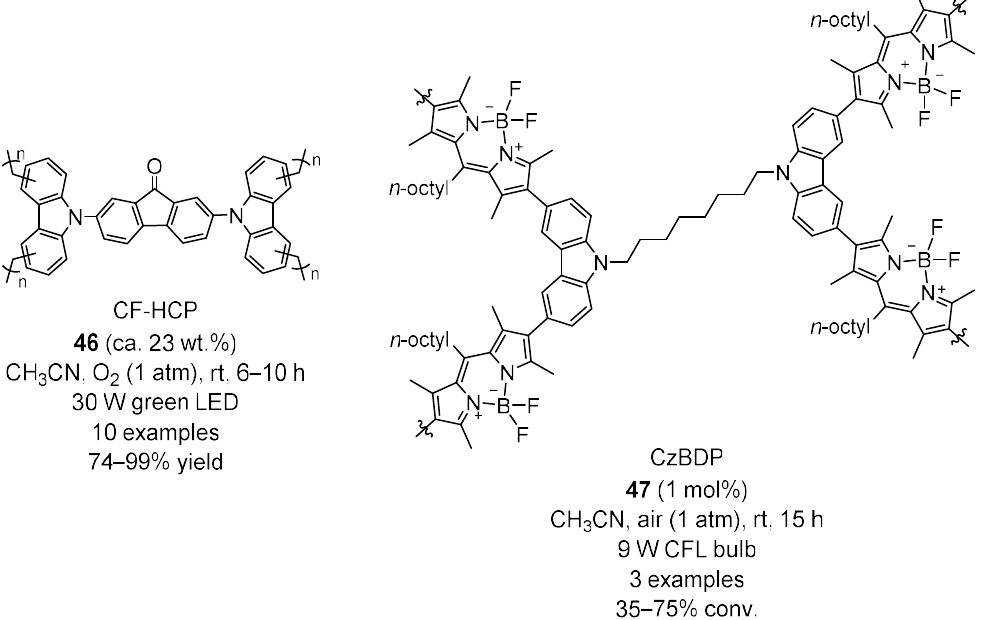
Figure 8. Results obtained in the aerobic photo-oxidative coupling of benzylamines to N -benzylidene benzylamines 2 catalyzed by 46 and 47 .